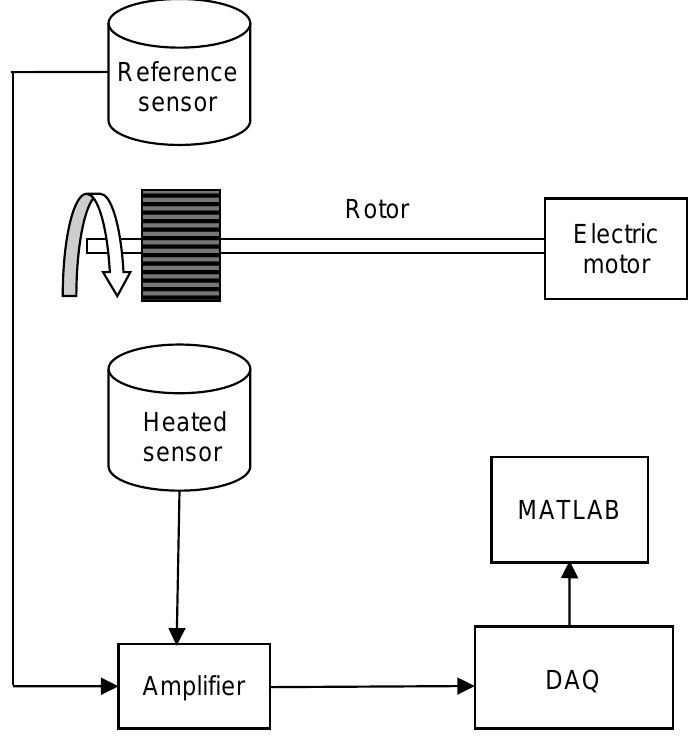
Figure 6. Scheme of the rotor rig and data